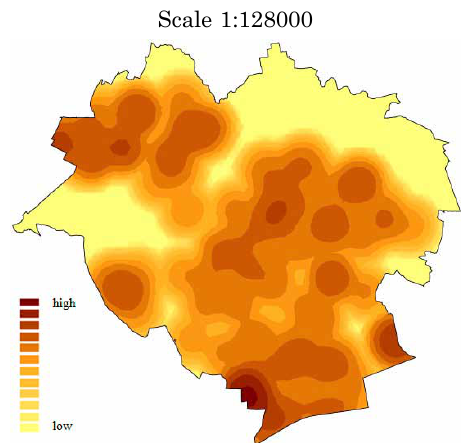
Fig. 7. Map of simulated transaction density (probability of transaction occurrence) Source : own